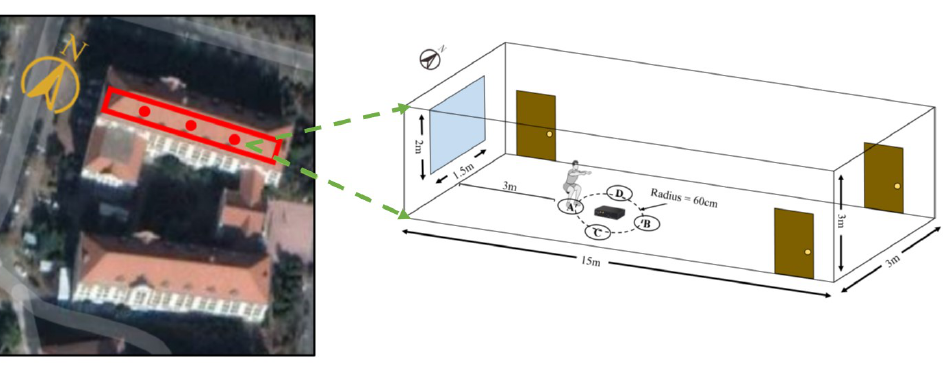
Figure 3. Corridor deployment for experimental